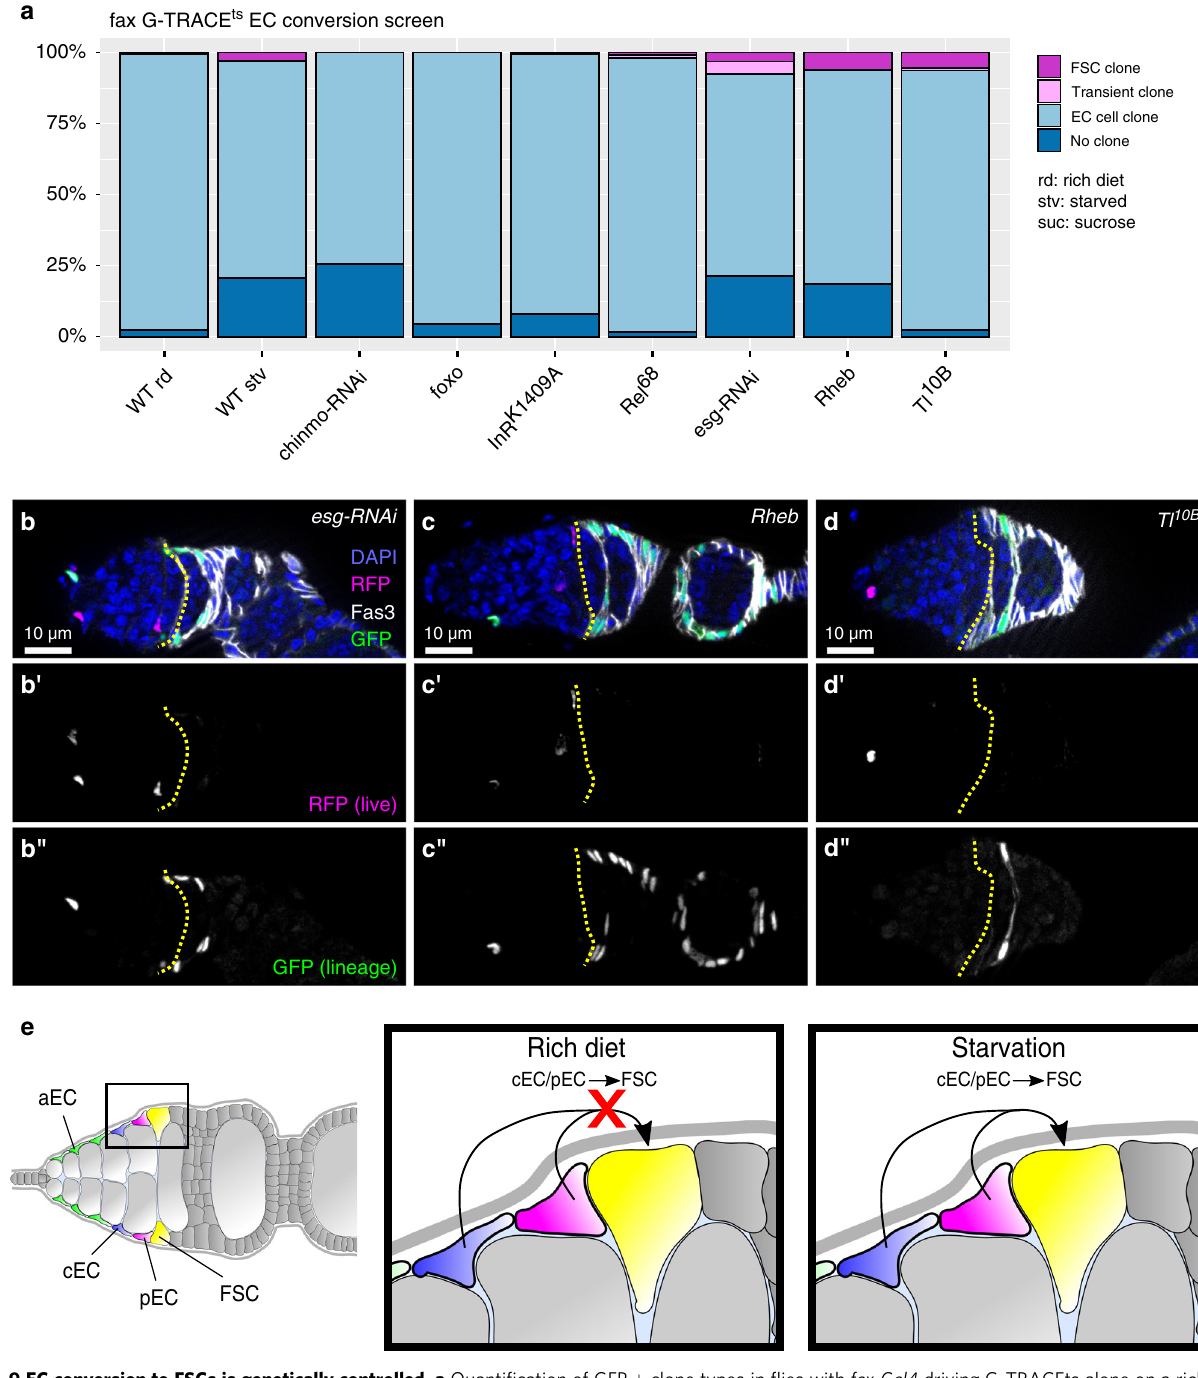
Fig. 9 EC conversion to FSCs is genetically controlled. a Quanti fi cation of GFP + clone types in fl ies with fax-Gal4 driving G-TRACEts alone on a rich diet (rd) for 14 days (WT rich diet); starved for 24 hrs within the 14 dpts (WT starved); or on a rich diet for 14 days in combination with chinmo or escargot RNAi knockdown, or overexpression of a dominant-negative allele of the insulin receptor ( InR K1409A ), a constitutively active allele of Relish ( Rel 68 ) or Toll ( Tl 10B ) or a wildtype allele of Rheb or foxo . p-values from two-sided Student ’ s T-test for comparisons between the frequency of follicle cell clones (FSC + transient) in WT rich diet 14d and mutant condition that have a p < 0.05: esg-RNAi : p = 0.008; Rheb : p = 0.03; Tl 10B : p = 0.03. n = 204 (WT rich diet), 213 (WT starved), 113 ( chinmo-RNAi ), 135 ( foxo ), 127 ( InR K1409A ), 125 ( Rel 68 ), 154 ( esg-RNAi ), 143 ( Rheb ), 118 ( Tl 10B ) ovarioles. b – d Germaria with fax-Gal4 driving expression of G-TRACE ts and esg-RNAi ( h ), Rheb ( i ), or Tl 10B ( j ) stained for GFP (green), RFP (magenta), Fas3 (white) and DAPI (blue). b ’ – d ’ RFP channel show in white. b ” – d ” GFP channel shown in white. GFP + follicle cell clones are present even though fl ies were maintained on well-fed conditions. Yellow line outlines the 2a/2b border. e Model summarizing our observations that starvation, but not well-fed conditions, induces central ECs and/or posterior ECs to convert to FSCs. EC: escort cell; rd: rich diet; stv: starved; suc: sucrose; aEC: anterior escort cell; cEC: central escort cell; pEC: posterior escort cell; FSC: follicle stem